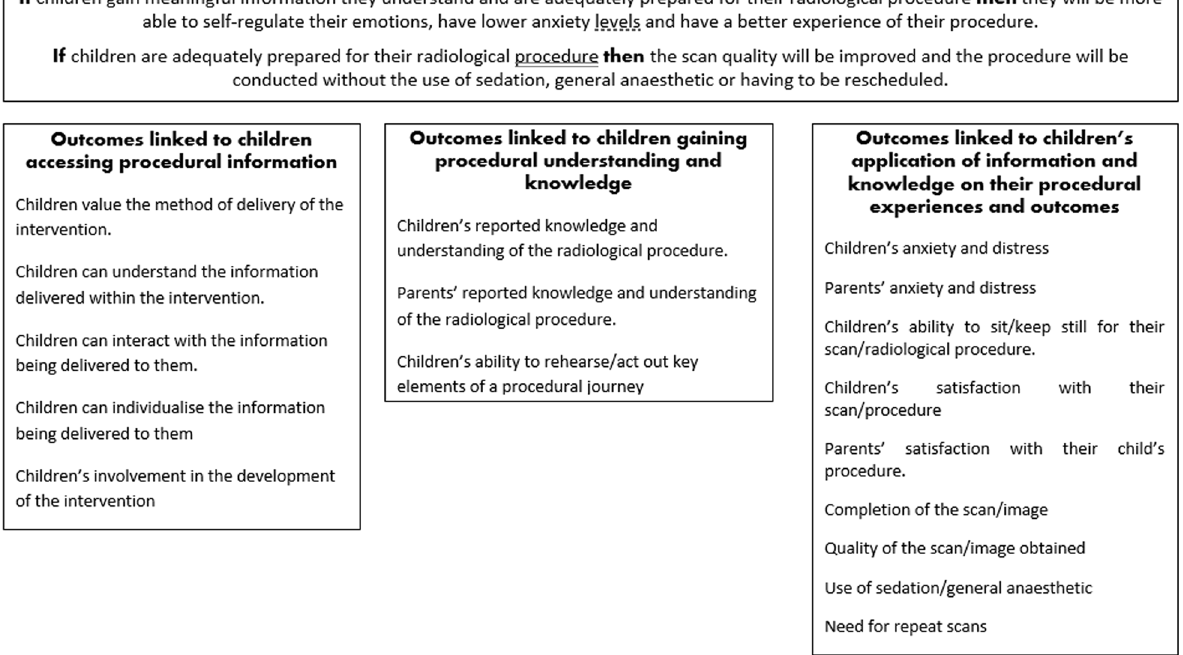
Fig. 2 Mapping the outcomes of interventions alongside a health literacy